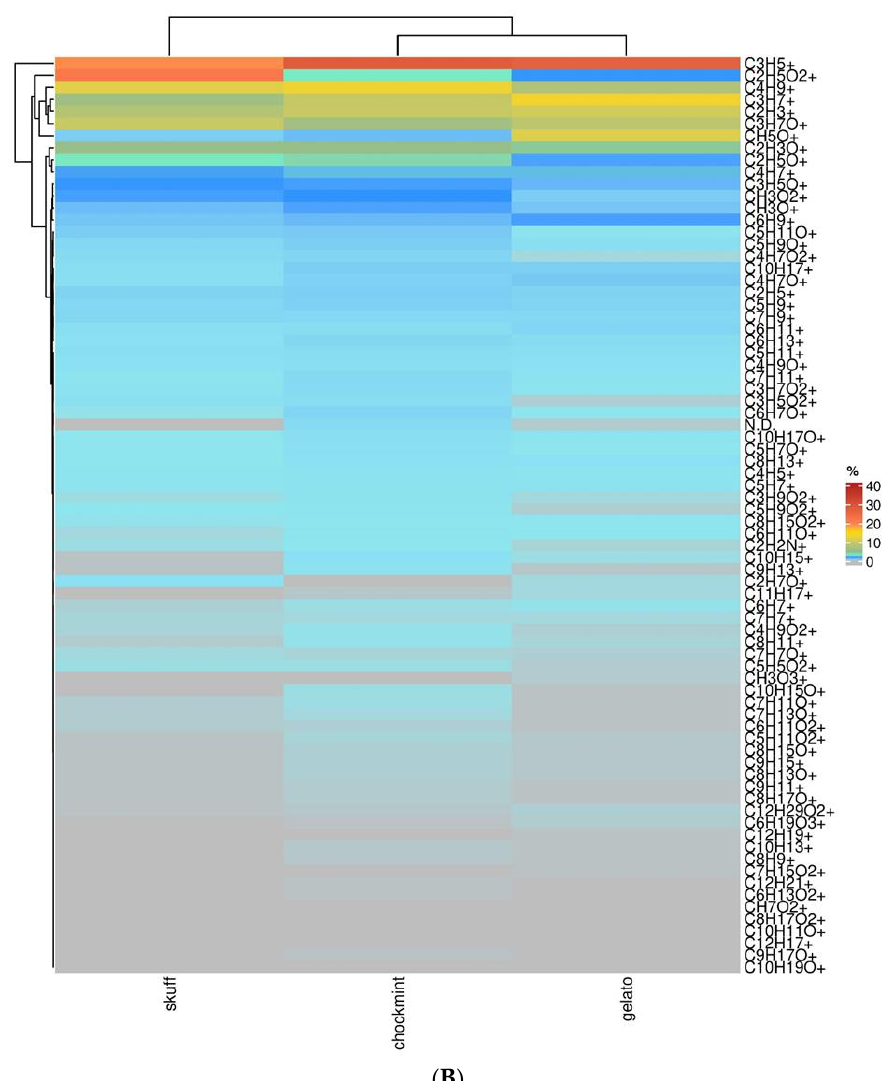
Figure 4. ( A ) Heatmap of metabolites percentage of the pollen samples deriving from the three cultivars. Each cultivar is indicated in the column, and every row indicates a compound. Red indicates high abundance, whereas compounds under the detection threshold are in gray. ( B ) Heatmap of metabolites percentage of the pollen hexanoic extract samples deriving from the three cultivars.